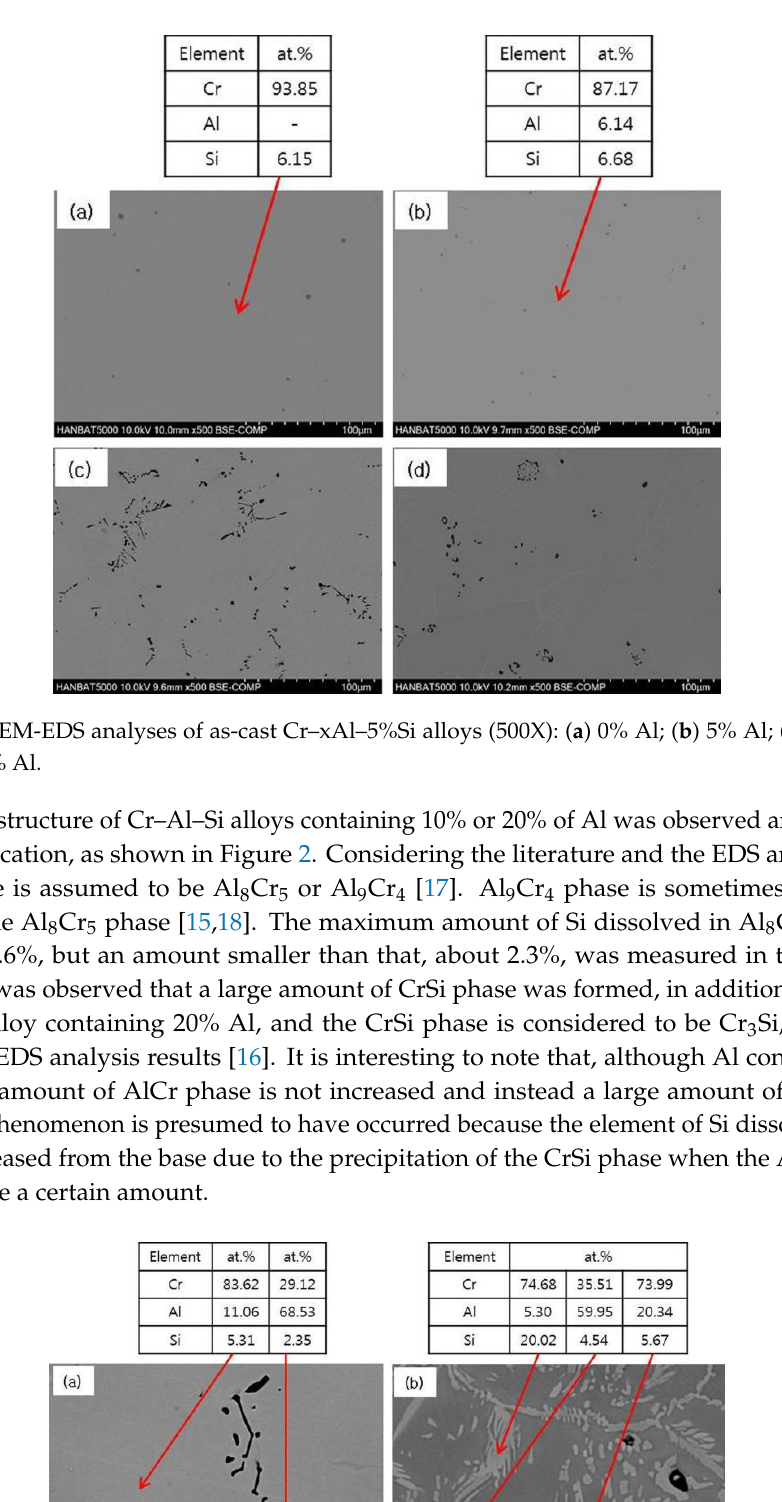
Figure 3. Micro-hardness of as-cast Cr–xAl–5%Si alloys. 3.2. Microstructural Change after the High-Temperature Oxidation Test The microstructure of Cr–xAl–5%Si alloys with 5% and 10% Al after 1 h in air at 1100 °C is shown in Figure 4. The isothermally heated microstructure of 0% Al-added alloy is composed of virtually single Cr-phase structure, as in the cast state. In the case of 5% Al-added alloy, a few AlCr phases were formed after high-temperature heating, unlike the casting state, and it is presumed that this phase was mainly formed during the cooling process. In the case of 10% Al-added alloy, more AlCr phases were formed than in 5% Al-added alloy, and any CrSi phases were not observed in both alloys. Figure 5 shows the microstructure after heating 20% Al-added alloy at 1100 °C, and it can be seen that a large amount of Cr 3 Si phase, which is seen as a bright color, was formed. Occasionally, Al-rich phases were observed in some regions, but the Al 8 Cr 5 (or Al 9 Cr 4 ) phases, which were observed in the cast microstructure, could no longer be found. Due to solidification segregation, there can be regions with high Al concentration in the cast specimen, where small liquid pools may be formed during the high-temperature heating. It is estimated that a few Al-rich phases were formed during the solidification of the liquid parts.